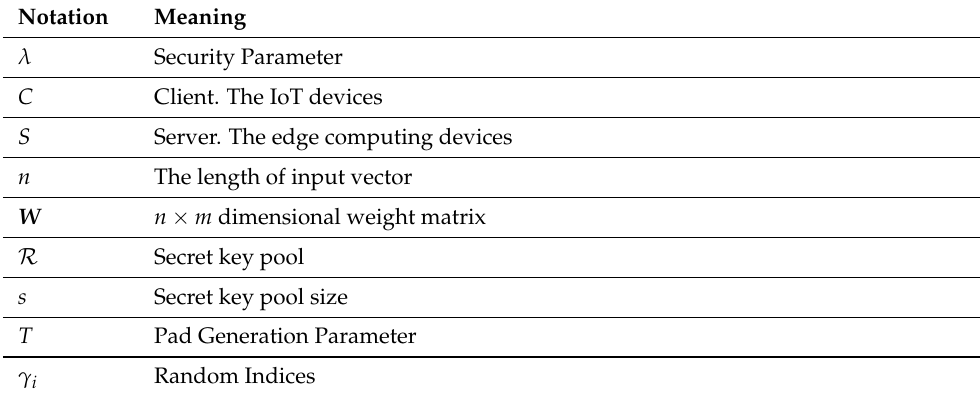
Table 1. Summary of notation and